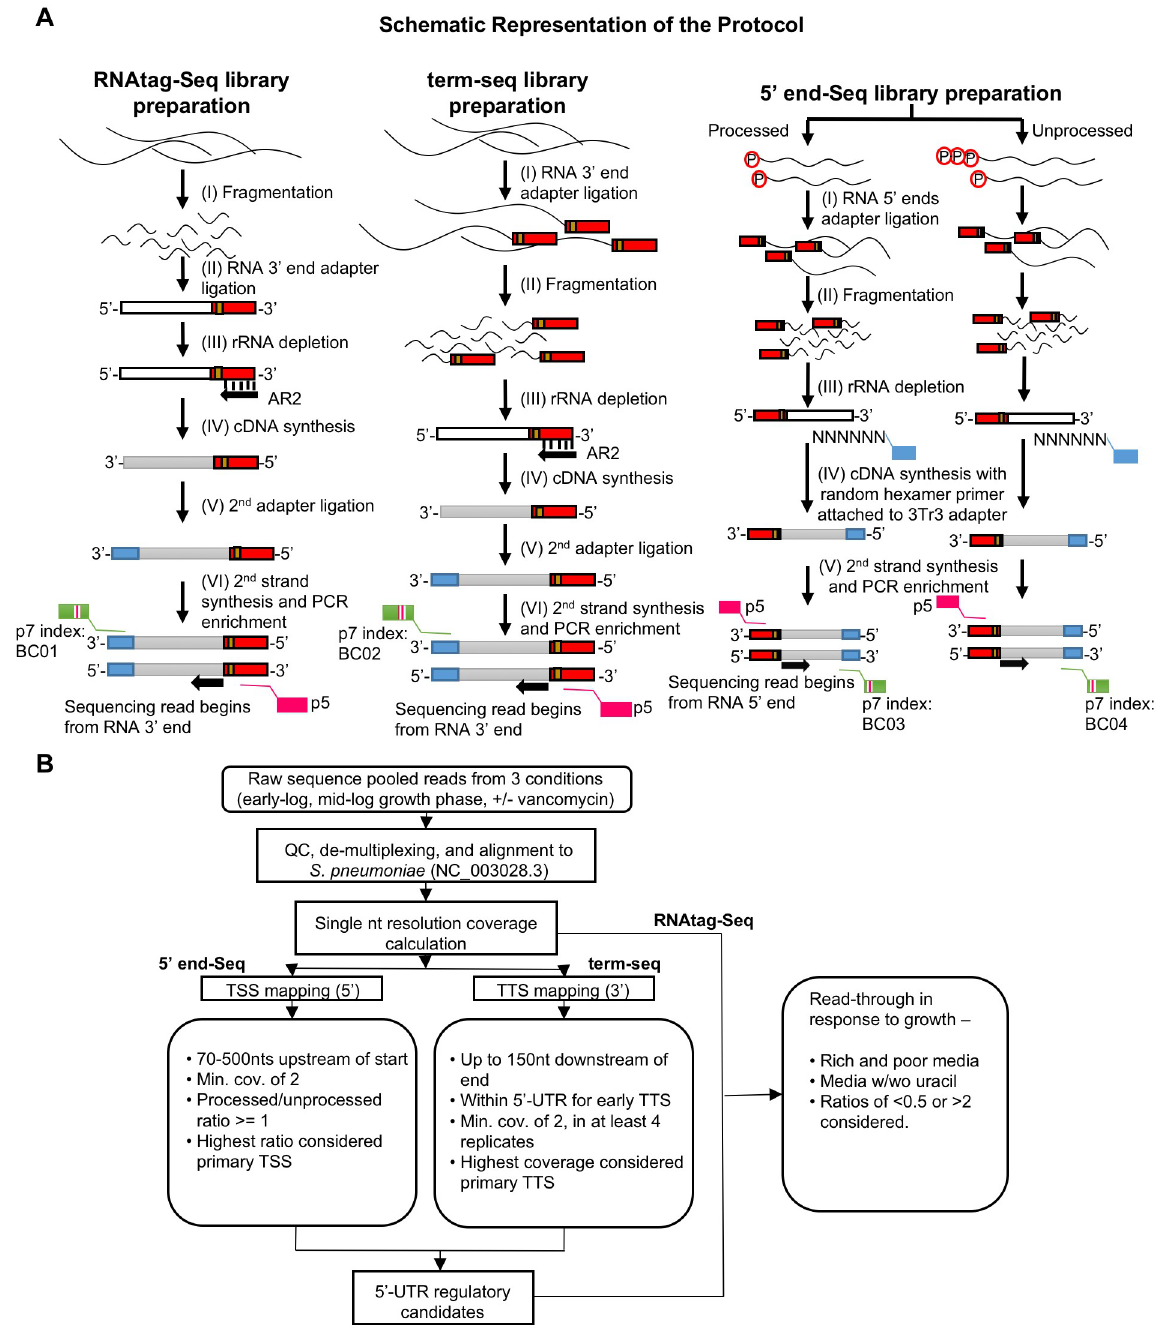
Fig 1. Schematic representation of the sequencing and data analysis methodology. (A) A description of the experimental pipeline. RNA-Seq (left column) and term-seq (middle column) libraries were prepared according to protocols described in [34,35].5’ end-Seq libraries (right column) were generated by dividing the total RNA into 5’ polyphosphate treated (processed) and untreated (unprocessed) samples and subsequently processed according to protocols described in [22,64].White and grey lines correspond to RNA and cDNA, respectively and colored blocks represent unique sequence barcodes. Illumina sequencing adaptors with index barcodes are also indicated. (B) A brief description of the analysis pipeline. Raw reads from all three sequencing methodologies obtained from three environmental conditions (early- log and mid-log growth phase in the presence and absence of vancomycin) were de-multiplexed and aligned to T4 (NC_003028.3). Based on the reads mapped, single nucleotide coverage was calculated. Coverage of the 5’ end of the reads calculated for the 5’ end-Seq was used to determine the transcription start sites. Coverage of the 5’ end of the reads from term-seq was used to determine the transcription termination sites. RNA-Seq coverage was used to calculate the read-through across candidate 5’ untranslated regions with early transcription terminators. Read-